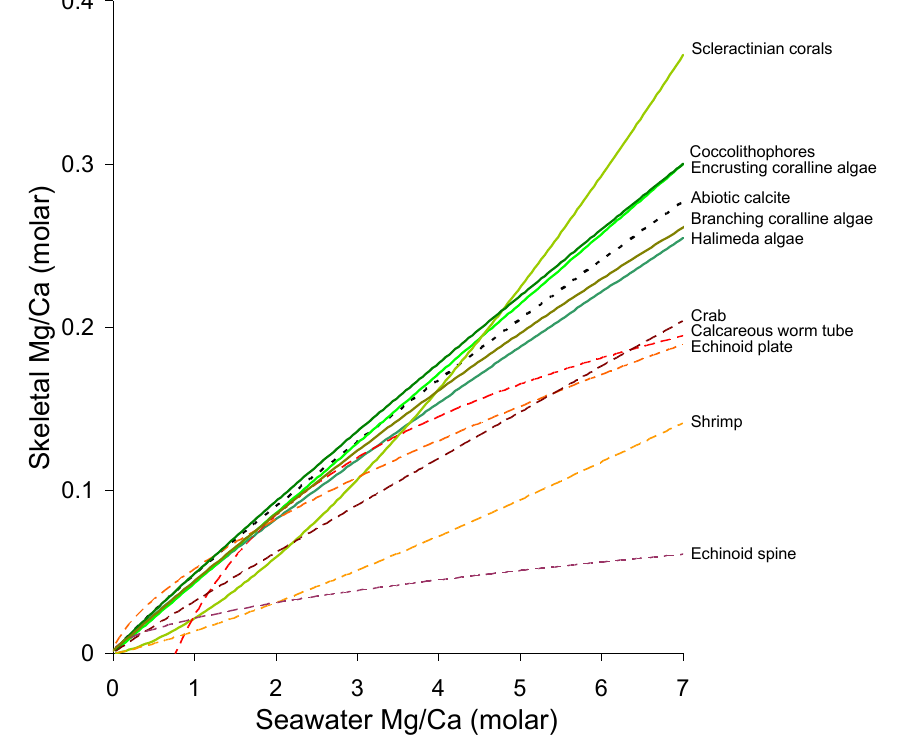
Fig. 30. The relationship between skeletal Mg/Ca and seawater Mg/Ca for organisms that secrete at least part of their skeleton as calcite. Solid lines are Mg fractionation curves for photosynthetic organisms: the two coccolithophores Pleurochrysis carterae and Ochrosphaera neopolitana (Stanley et al., 2005); the encrusting coralline red algae Neogoniolithon sp. (Ries, 2006b); the scleractinian corals Porites cylindrica , Montipora digitata , and Acropora cervicornis (Ries et al., 2006); three species of branching coralline algae of the genus Amphiroa (Stanley et al., 2002); and the bryopsidalean alga Halimeda incrassata (Stanley et al., 2010). Dotted line is Mg fractionation curve for abiotic calcite (F¨uchtbauer and Hardie, 1976). Dashed lines are Mg fractionation curves for non-photosynthetic organisms: the echinoid Eucidaris tribuloides ; the crab Perchon gibbesi ; the shrimp Palaemonetes pugio ; and the calcareous serpulid worm Hydroides crucigera (Ries, 2004). Photosynthetic organisms appear to be more influenced by ambient seawater Mg/Ca than non-photosynthetic ones. From Ries